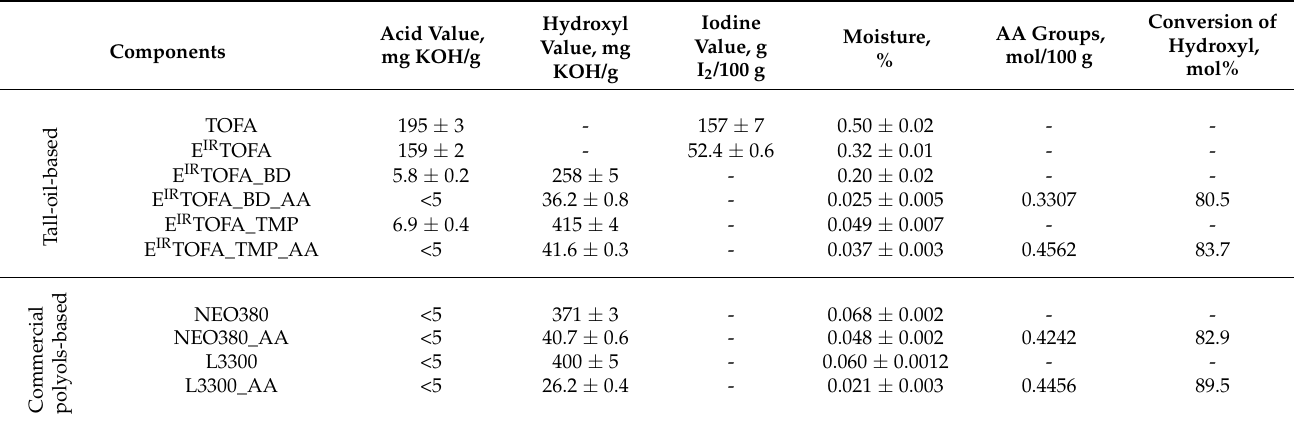
Table 1. The acid, hydroxyl, epoxy and iodine values, as well as moisture and acetoacetate group content of: synthesized tall-oil-based polyols and their acetoacetates, and commercial polyols and their acetoacetates.